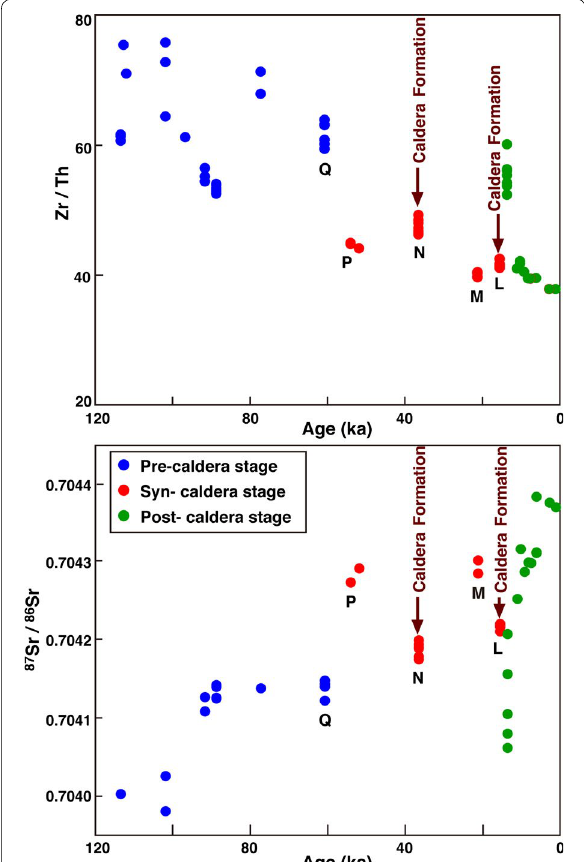
Fig. 12 Temporal variations of Zr/Th and 87 Sr/ 86 Sr in the products of Towada Volcano. Data are from this study (Additional file 1: Appendix 1) and Hunter and Blake (1995)